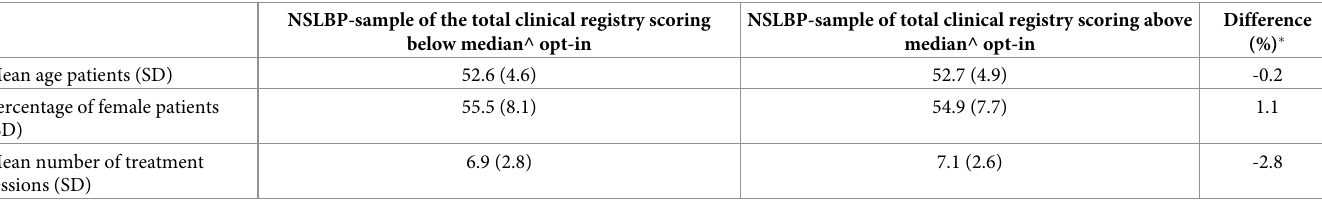
Table 4. Reliability analysis on selection bias using the NSLBP sample (N = 213,245 patients from 865 PT practices) of the total clinical registry: A within groups comparison on descriptive statistics using the median opt-in to divide the NSLBP sample into two